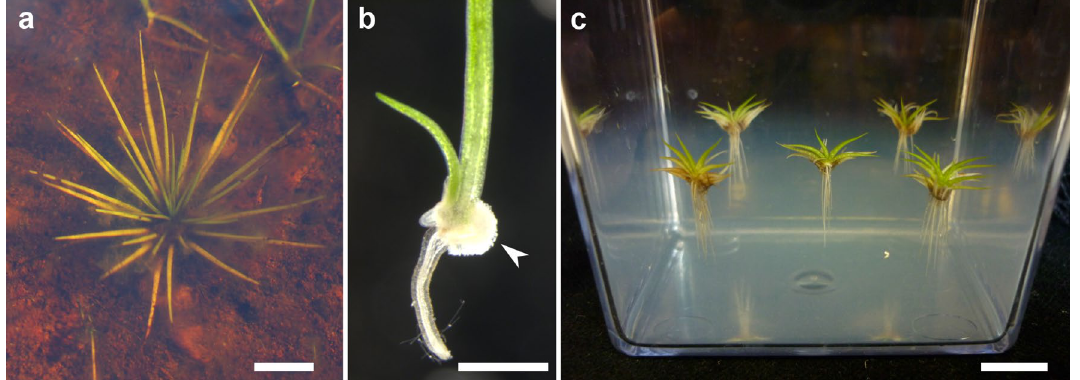
Figure 1. Growth of I. echinospora in axenic culture for RNA extraction. ( a ) I. echinospora growing submerged in its natural habitat, North West Sutherland (Scotland, UK). ( b ) Developing sporophyte emerging from the megaspore (highlighted with arrowhead) at the two leaf-, two rootlet-stage ( C ) I. echinospora sporophytes growing submerged on transparent solid media. Scale bars: ( a ) approximately 2 cm; ( b ) 1 mm; ( c ) 1 cm.